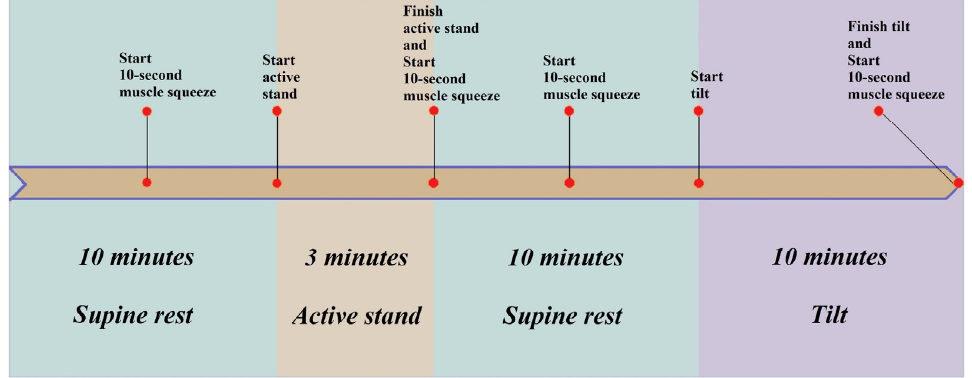
Figure 1. Diagram of the NCVI/NMFI assessment protocol. It was composed of a 10 min supine rest and a 3 min active stand, followed by a 10 min supine rest and a 10 min head-up tilt. With four prompted muscle contractions of the thighs introduced at different stages of the assessment, a total of six events were included (see text for further protocol details).